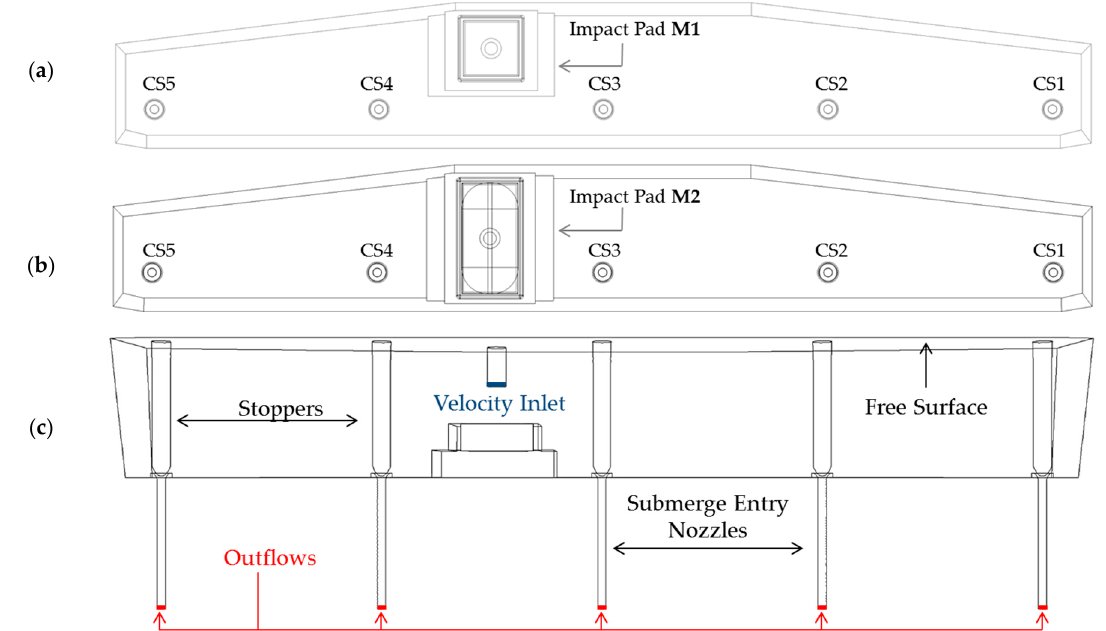
Figure 1. 3D geometry of the modelled area, where ( a ) represents the floor plan of the tundish with the impact pad design M1 ( b ) represents the floor plan of the tundish bottom with the impact pad design M2 ( c ) front view of the tundish with elevated position of the impact pad, which is identical for both designs (i.e., M1 and M2). CS1–CS5 are Casting Strands. Table 1. Boundary conditions of model setting.